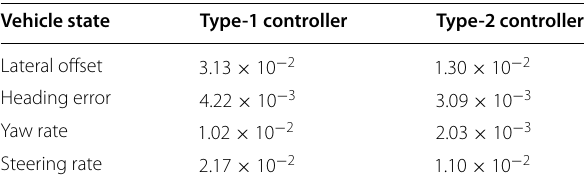
Table 3 Infinite norm of vehicle states responding to given road